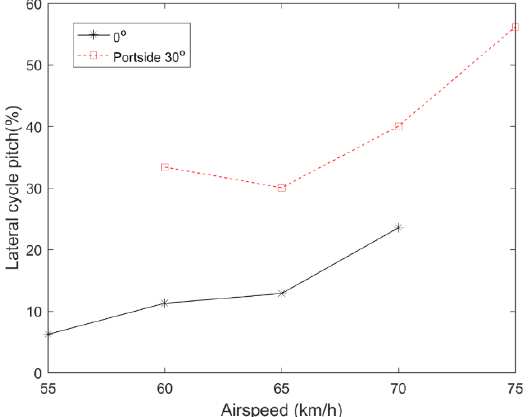
Figure 19. Lateral cycle pitch under 0° and portside 30° WOD conditions.